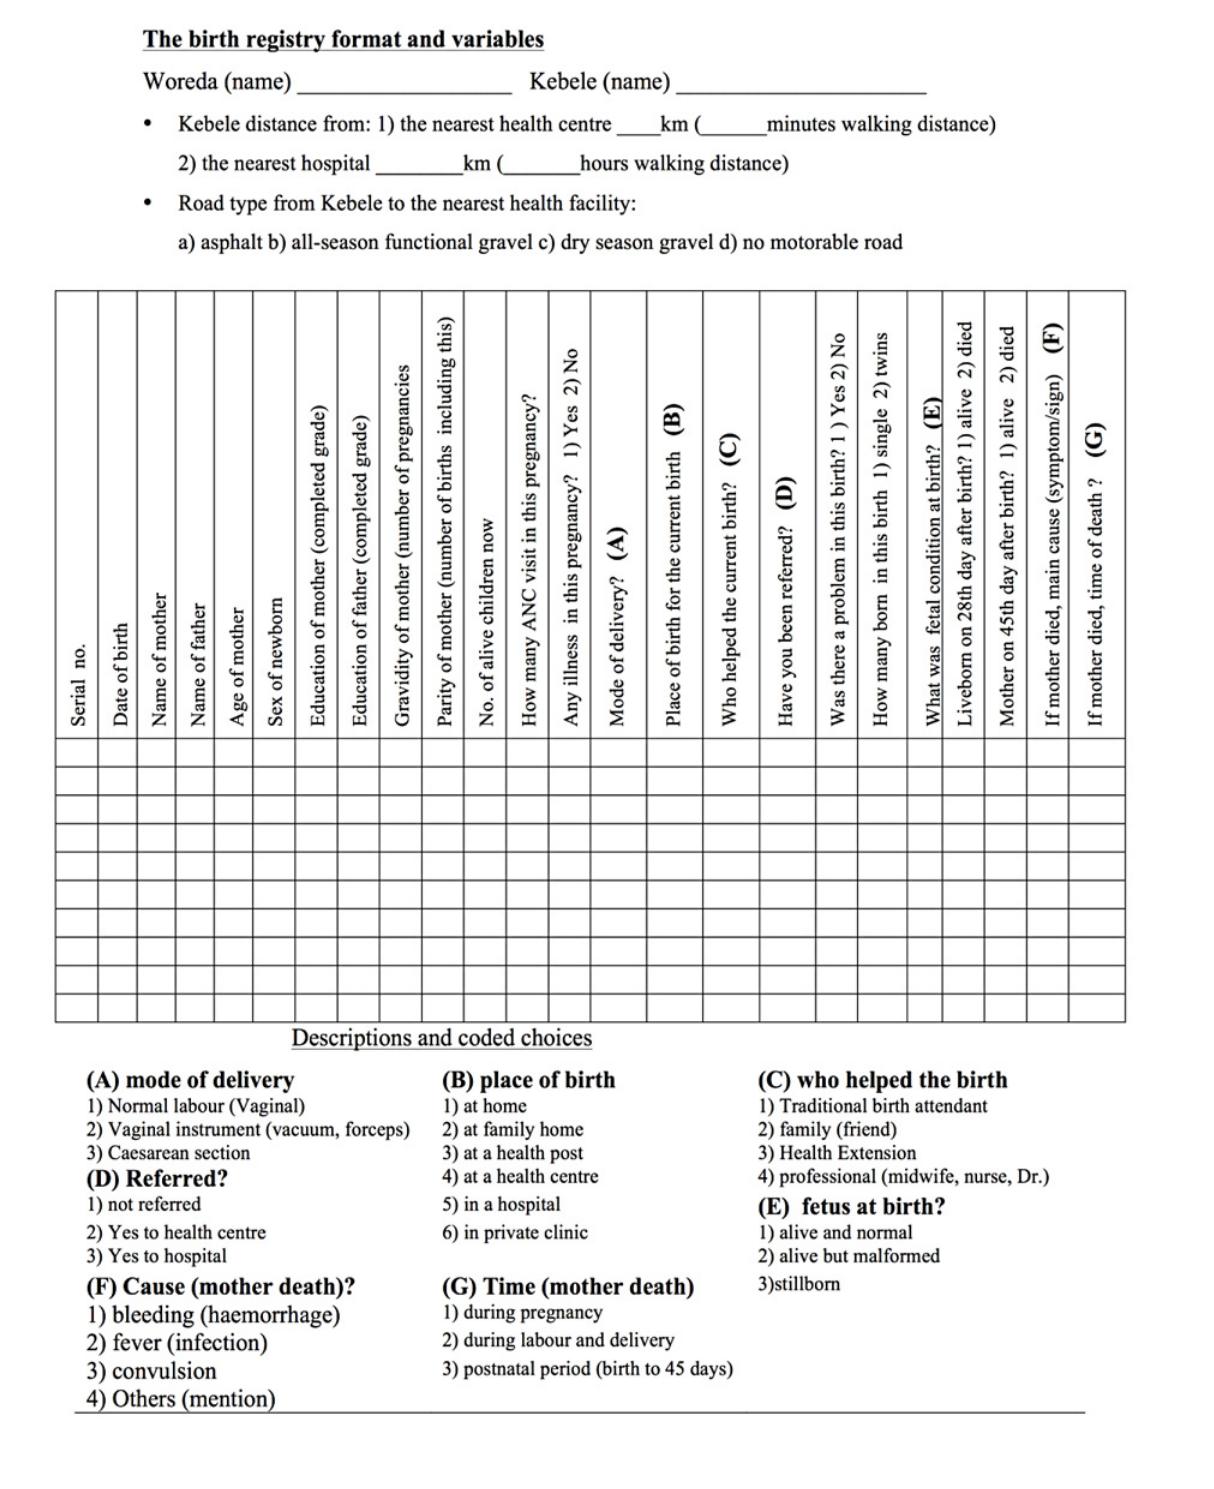
Fig 3. The birth registry format.